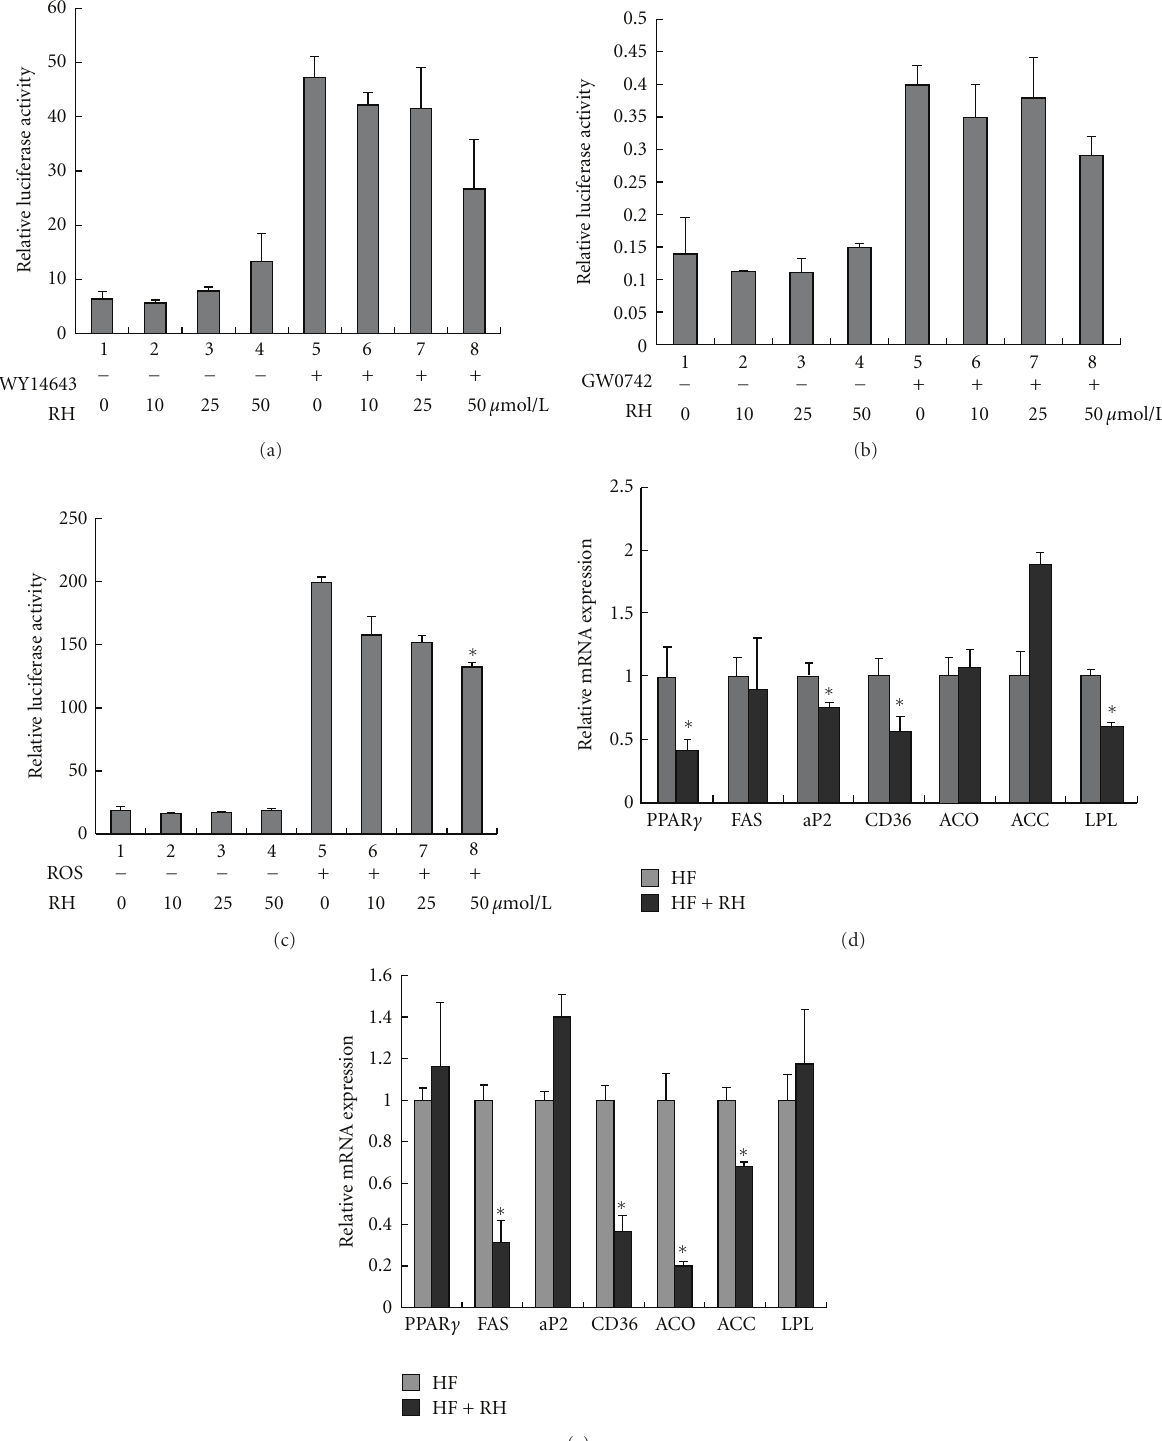
Figure 4: Rhein regulates the transcription activity of PPAR γ . ((a)–(c)) The transcription activity of PPAR α , γ , β / δ . GAL4-DBD-LBD expression plasmids and a GAL4-responsive luciferase reporter were cotransfected into HEK293T cells for 24 h and treated with the PPAR γ , PPAR α , and PPAR β / δ agonist rosiglitazone, WY14643, GW0742 (10 μ M), and rhein (10, 25, and 50 μ M) for another 24h. Rellina-luc was used as the transfection e ffi ciency control, and the relative luciferase activities were measured by comparison to renilla luciferase activities. The results represent at least three independent experiments, and data are presented as means ± SE. (d) The relative expression levels of PPAR γ target genes in WAT. (e) The relative expression levels of PPAR γ target genes in the liver tissue. β -actin was used as an internal control for modifying the mRNA level. HF: high-fat diet. RH: rhein. Values are mean ± SE for 7 mice per group. ∗ P < 0 . 05 versus HF